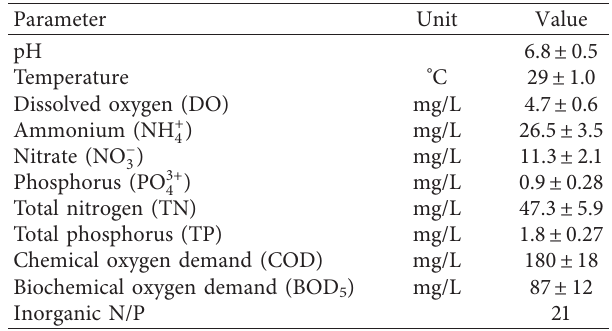
Table 1: The average composition of the wastewater (average ± SD of five